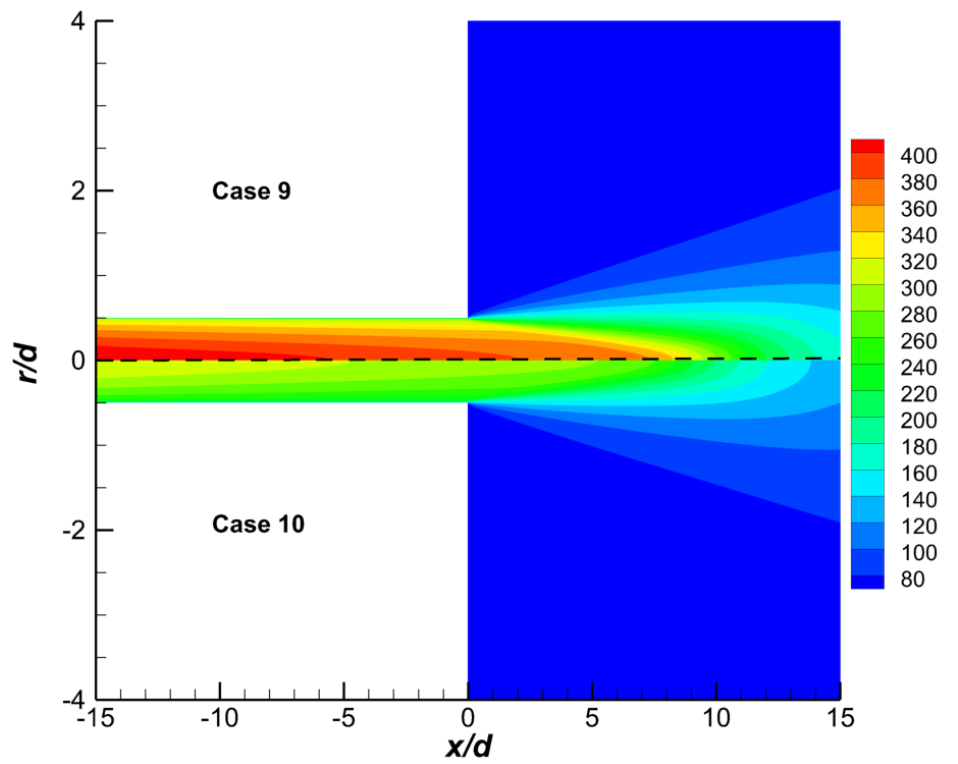
Figure 14. Density field comparison for cases 9 and